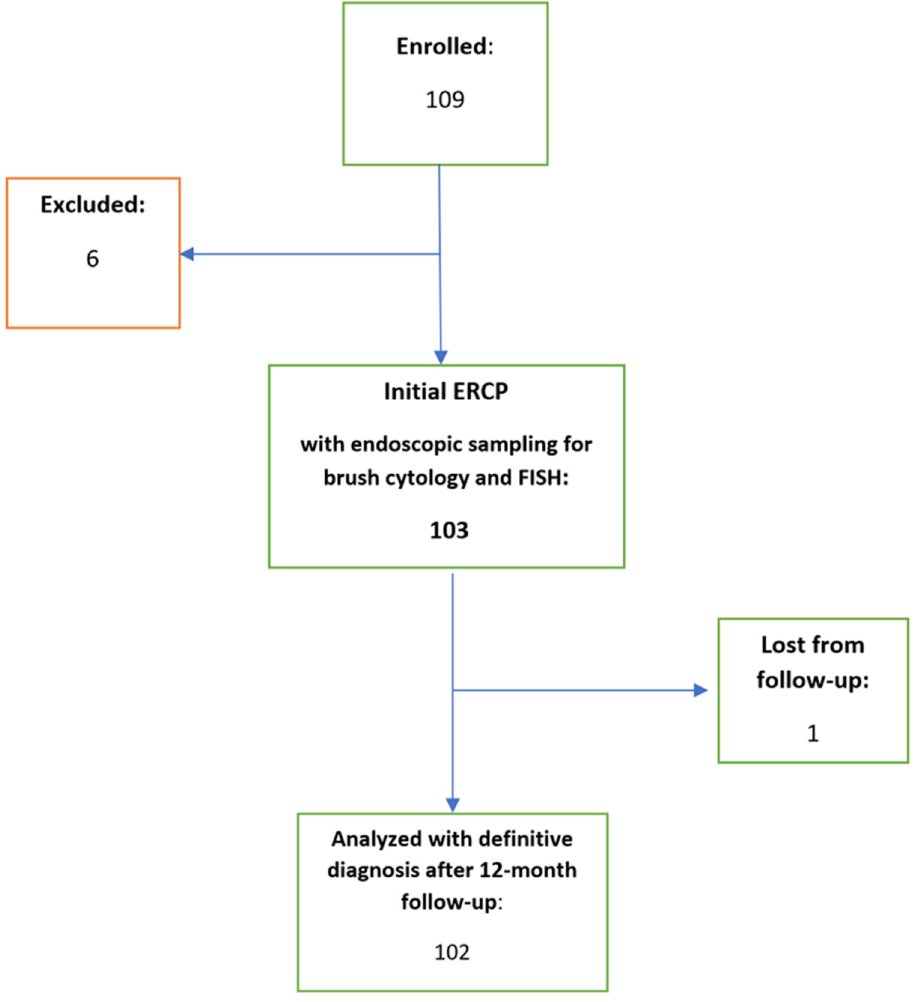
Figure 3. Study flow chart. Benign strictures were diagnosed in 28 (27.5%) patients and malignancy in 74 (72.5%) patients, including 25.5% with cholangiocarcinoma and 37.3% with pancreatic tumors. A total of three (2.9%) patients had primary sclerosing cholangitis (PSC), two of them